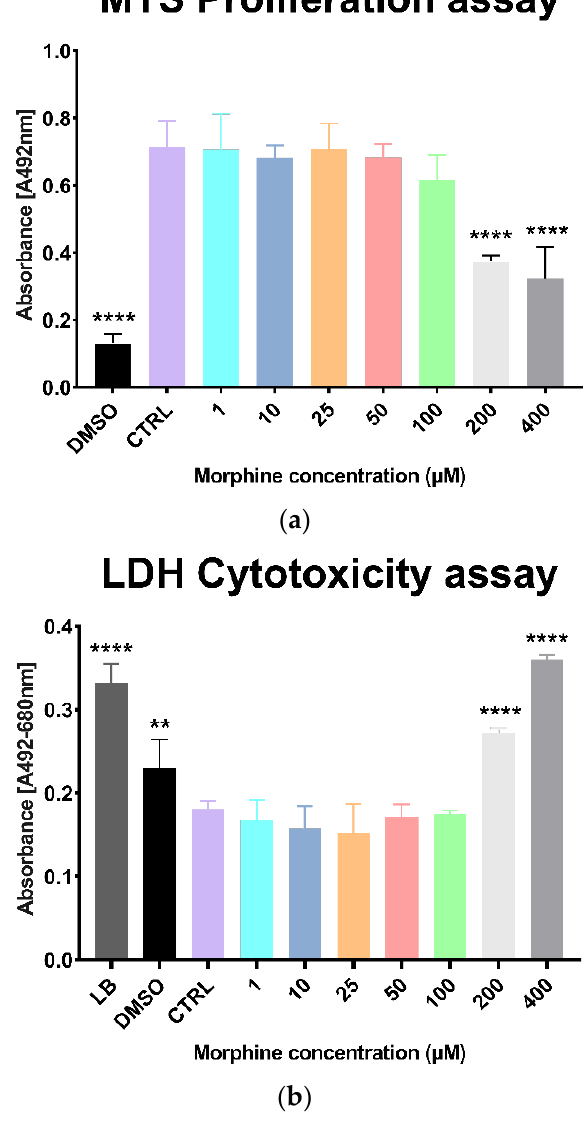
Figure 1. MTS proliferation assay and LDH cytotoxicity assay on morphine-exposed human brain microvascular endothelial cells. ( a ) MTS assay of 24 h of morphine treatment to determine viability of human brain endothelial cells. DMSO = dimethyl sulfoxide. Mean ± SD, n = 3, **** p < 0.0001. ( b ) LDH assay of 24 h of morphine treatment to determine cytotoxicity of human brain endothelial cells. LB = lysis buffer, DMSO= dimethyl sulfoxide. Mean ± SD, n = 3, ** p < 0.01, **** p <